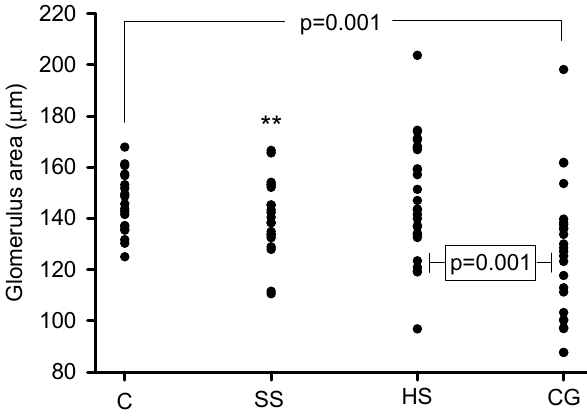
Figure 4. Representative photomicrographs of rat renal cortexes. Images show glomeruli from ( A ) control, ( B ) kidneys from rats that were injected with saline solution and ( C ) kidneys from rats that received serum from healthy subjects. No abnormalities were observed under light microscopy in these groups. There are open capillary loops and conserved spaces. ( D ) Cortexes from rats that received serum from patients having collapsing glomerulopathy. Glomeruli show podocyte hypertrophy, collapse and retraction of the glomerular tuft (400 × Jones’ methenamine silver reaction). There are a collapse of capillary loops and prominent visceral cells.